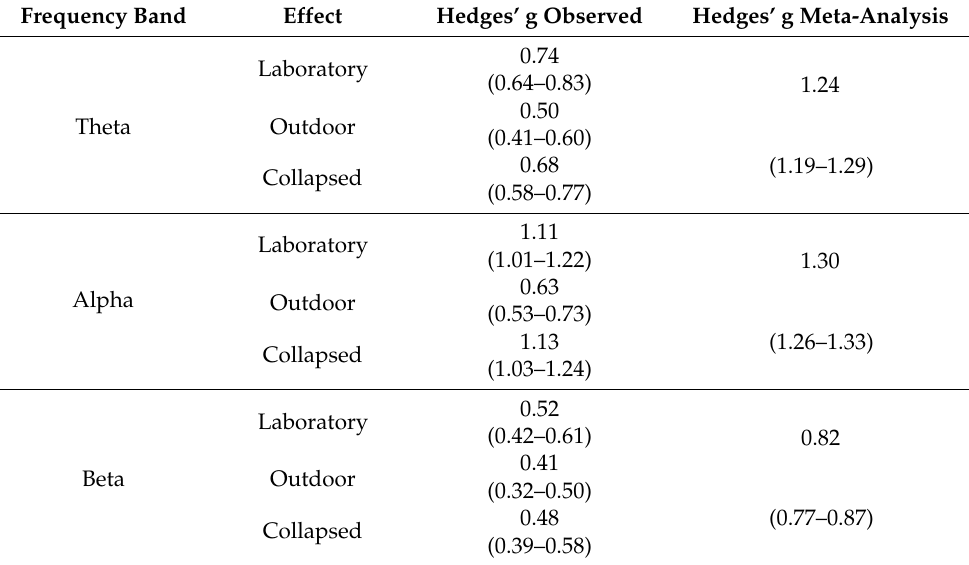
Table 8. Observed versus Meta-Analytic Hedges’ g for EEG Power Main Effect of Resting State.